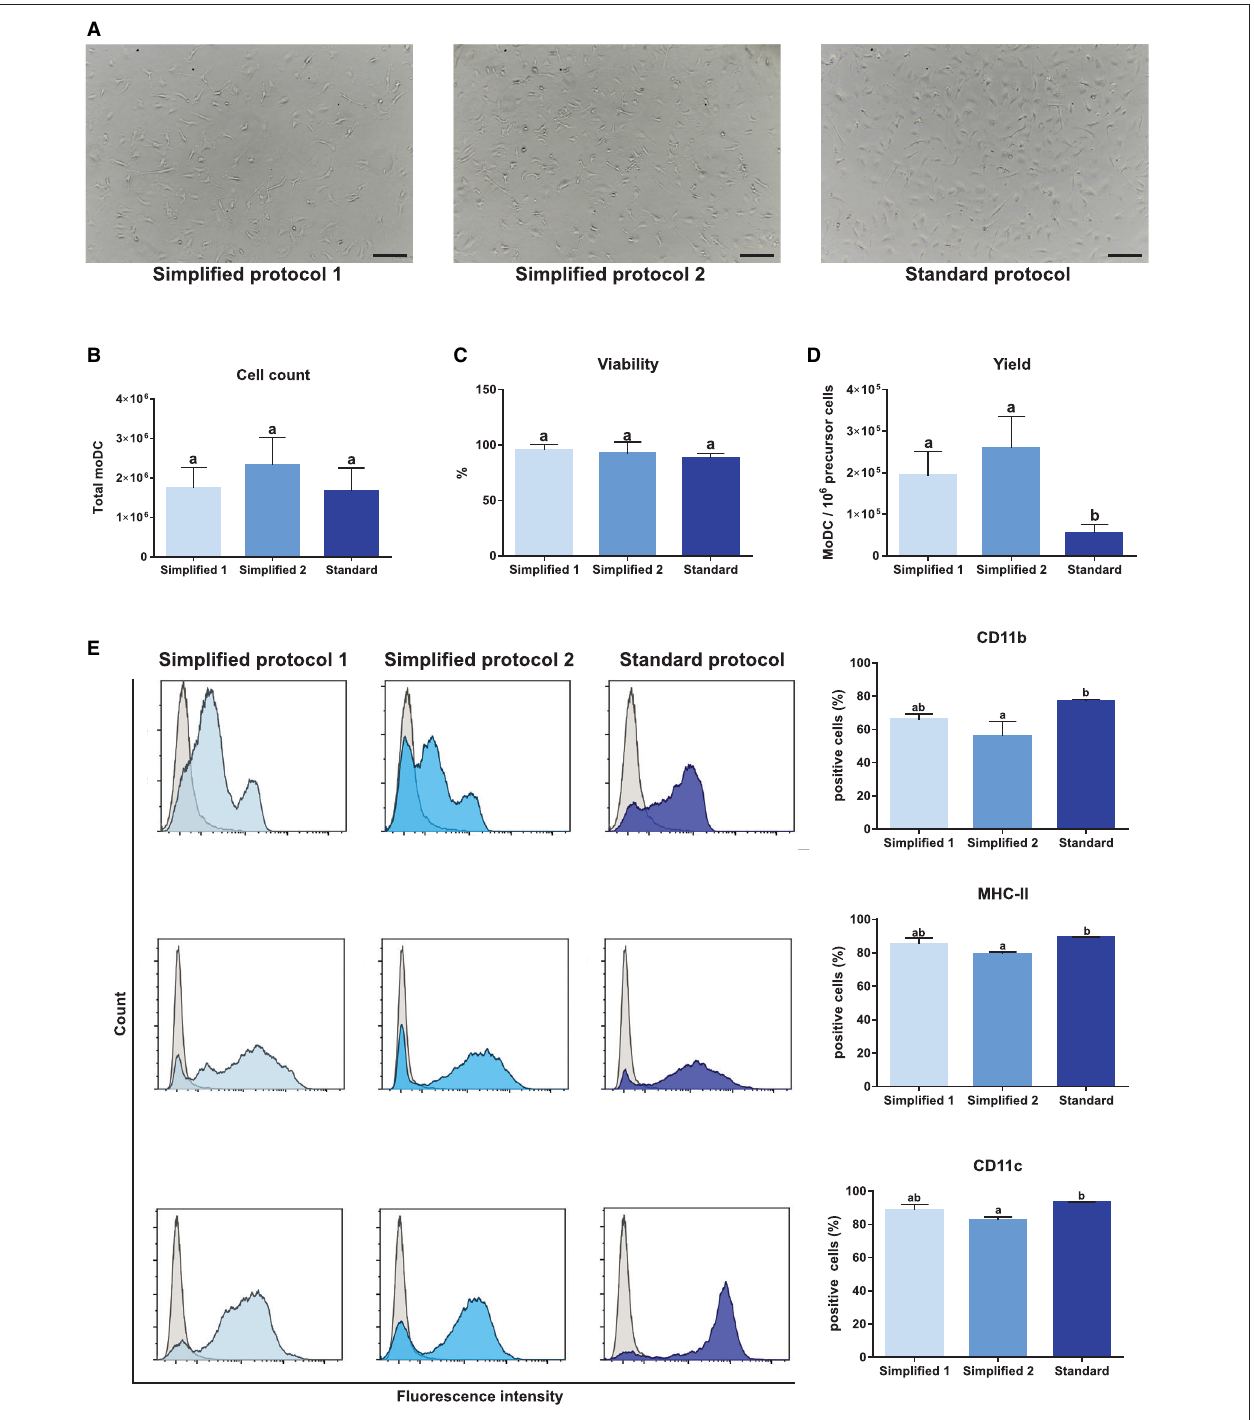
FIGURE 4 | Yield, viability, and phenotype of bovine moDC produced by 3 different approaches at day 6. (A) moDC microscopic images, 100X magnification. Scale bars correspond to 20 µ m. (B) Absolute moDC count. (C) Cell viability. (D) moDC count per 10 6 of precursor cells. Buffy coat, PBMC, and CD14 + monocytes were used as precursor cells in simplified protocol 1, simplified protocol 2, and standard protocol, respectively. (E) Analysis of the surface markers CD11b, MHC-II, and CD11c by flow cytometry. The histograms ( left ) show the results of one representative experiment. Gray and blue peaks correspond to isotype and marker specific labeling, respectively. Bar plots ( right ) depict the percentage of positive cells. In (B–E) , bar plots depict data from individual replicates obtained from at least 3 and 4 different animals, respectively. Different letters mean statistically significant difference ( p < 0.05). Error bars represent